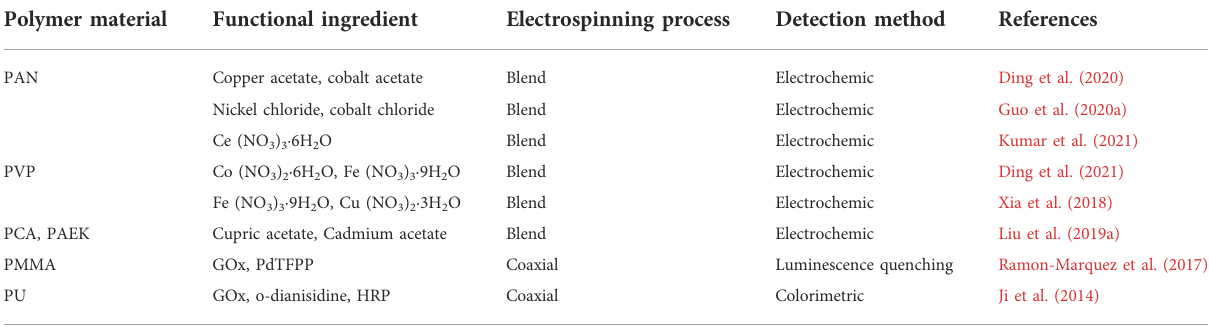
TABLE 2 Electrospinning processes and methods of detection in glucose sensors.